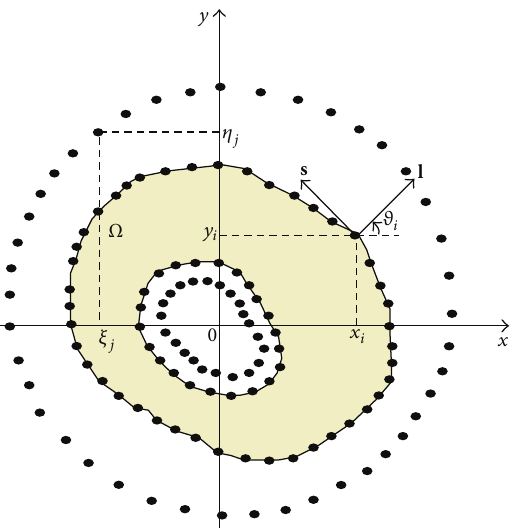
Figure 2: Domain Ω with singular points (𝜉 𝑗 ,𝜂 𝑗 ) lying on some external contour and points (𝑥 𝑖 , 𝑦 𝑖 ) lying on the boundary